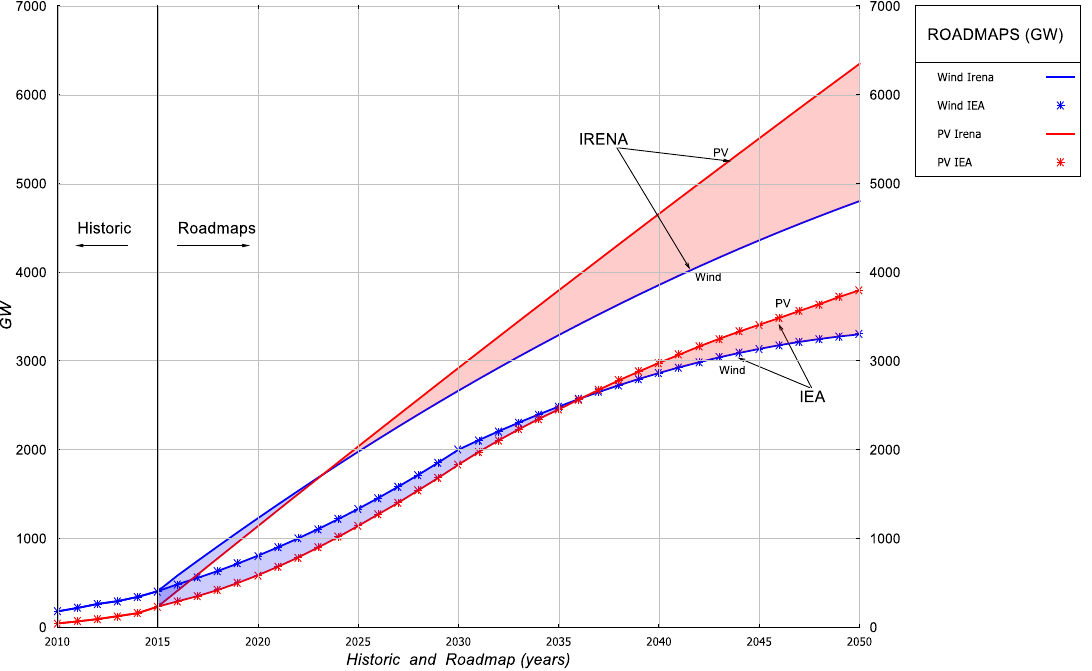
Figure 1. International Renewable Energy Association (Irena) and International Energy Agency (IEA): Wind and photovoltaic (PV) roadmaps.